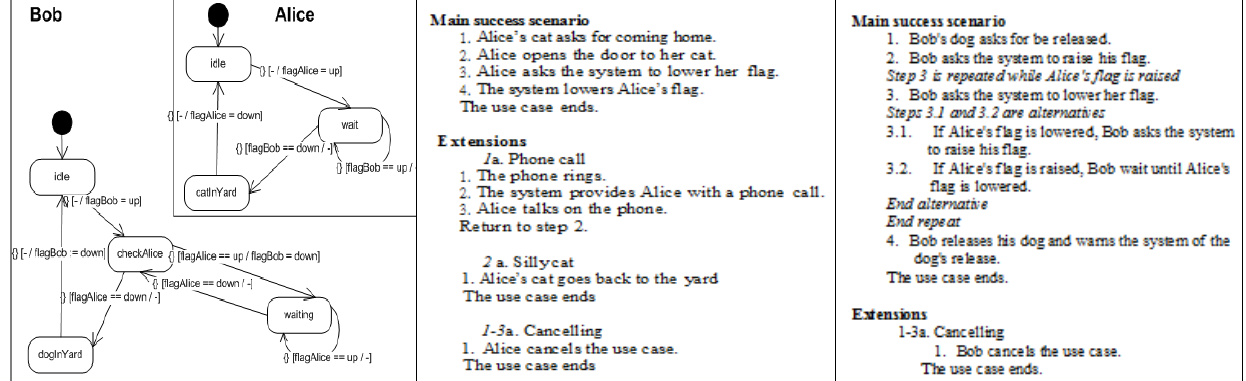
Figure 6. Automata of Alice and Bob behaviours (A) “ Alice’s cat comes home ” use case